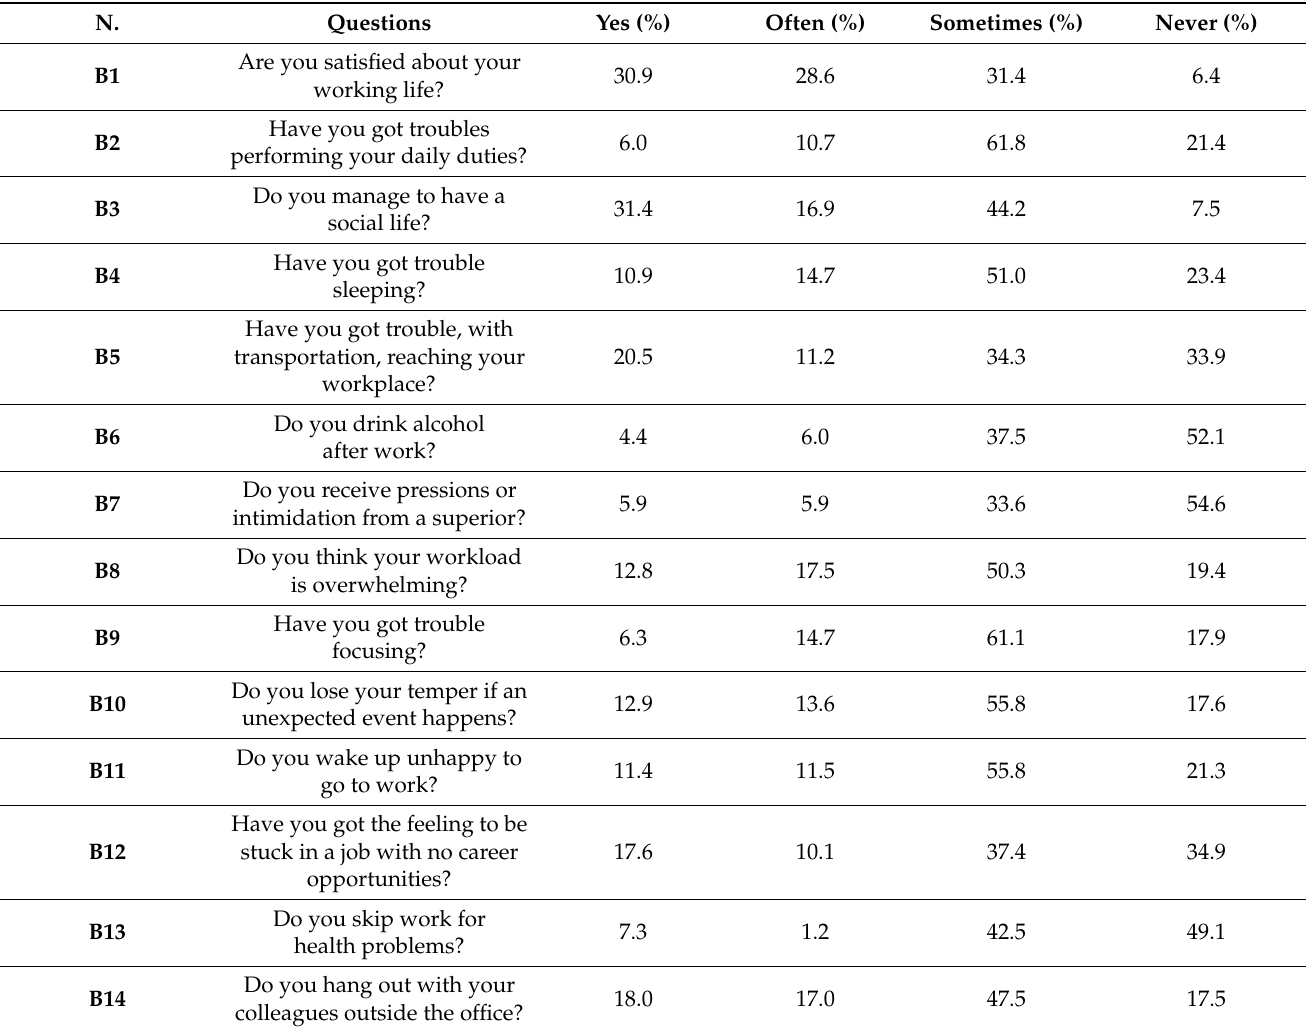
Table 4. Behaviour of respondents toward job